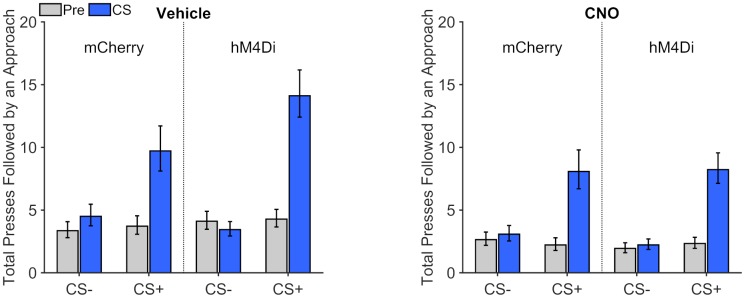
Frequency of lever presses that were followed by a food-cup approach during PIT testing by rats expressing the inhibitory DREADD hM4Di or mCherry following vehicle or CNO (5 mg/kg) treatment in Experiment 2.Data from pre-CS (gray) and CS (blue) periods are plotted separately. Error bars represent ±1 standard error of the estimated marginal means from the corresponding fitted generalized linear mixed-effects model. We found that the CS+ but not the CS- strongly increased the frequency of these press-approach sequences (CS Period * CS Type interaction, t(240) = 7.87, p<0.001), which did not vary as a function of Group or Drug treatment (interactions involving these factors, ps ≥. 18). However, while CNO administration did not disrupt the ability of the CS+ to elicit these press-approach sequences, it did result in a general, hM4Di-independent reduction in the frequency of these sequences (Drug effect, t(240) = −4.52, p<0.001; Drug * Group interaction, t(240) = −1.19, p=0.234).